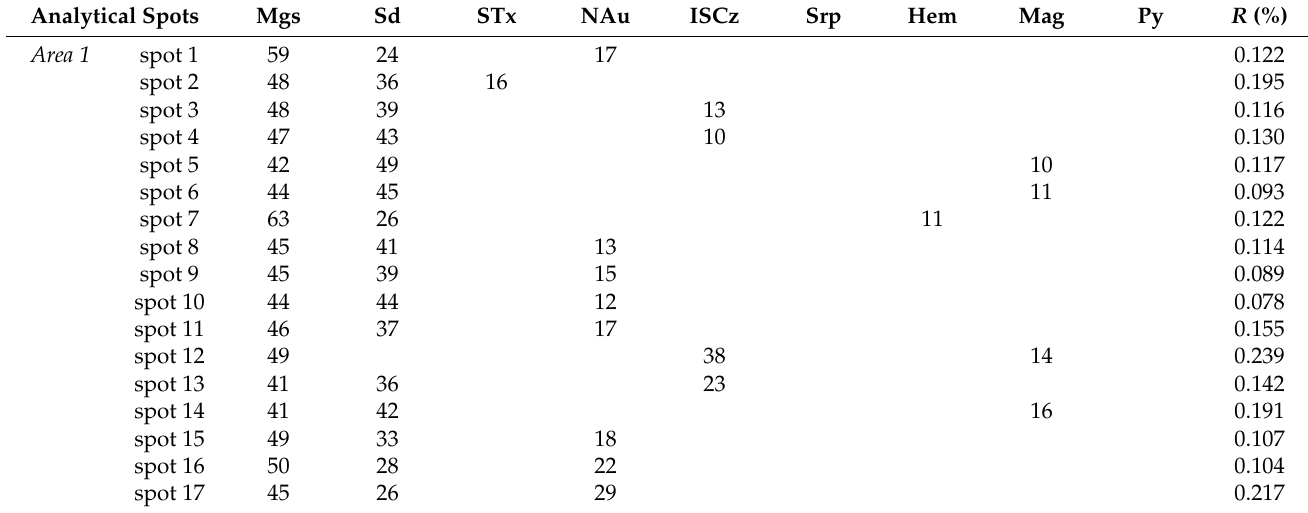
Figure 3. Iron K-edge EXAFS spectra of ( A , B ) standard minerals used to fit the measured ALH carbonate samples, and ( C – F ) µ -EXAFS analytical spots with fitting results. The solid black line denotes the measured spectra, and the blue circle shows the results of the fit using the parameters listed in Table 2. The detailed data are available in Supplementary Material Data S1. Table 3. The linear combination fitting (LCF) result of the Fe K-edge µ -EXAFS